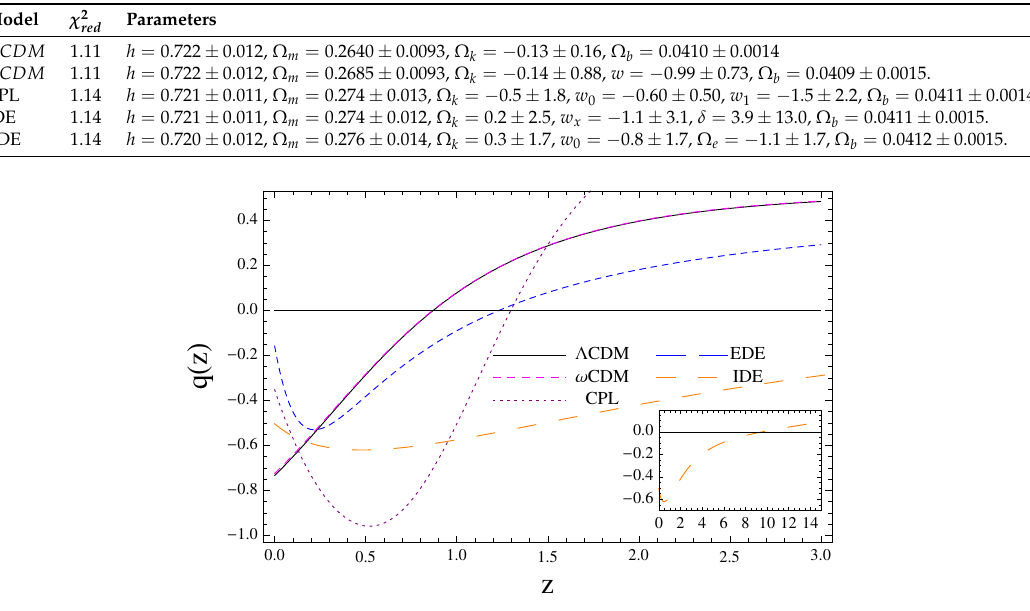
Figure 2. Deceleration parameter vs. redshift using only GC data ( d A + f gas ). The transition redshift z t between phases decelerated-accelerated ( q ( z t ) = 0) and the current value of deceleration parameter q 0 are shown for Λ CDM ( z t ∼ 0.86, q 0 = − 0.76), ω CDM ( z t ∼ 0.86, q 0 = − 0.76), CPL ( z t ∼ 1.32, q 0 = − 0.35), IDE ( z t ∼ 9.78, q 0 = − 0.50) and EDE ( z t ∼ 1.22, q 0 = − 0.17). Notice the strange behavior of the deceleration parameter to later times for models of dynamical DE models CPL, IDE and